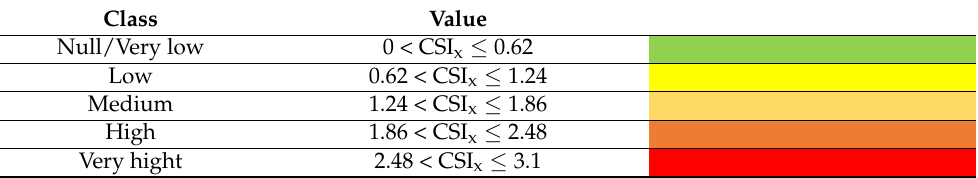
Table 5. The obtained five Coastal Susceptibility Inex classees indicating – from green to red- an increase of cliff